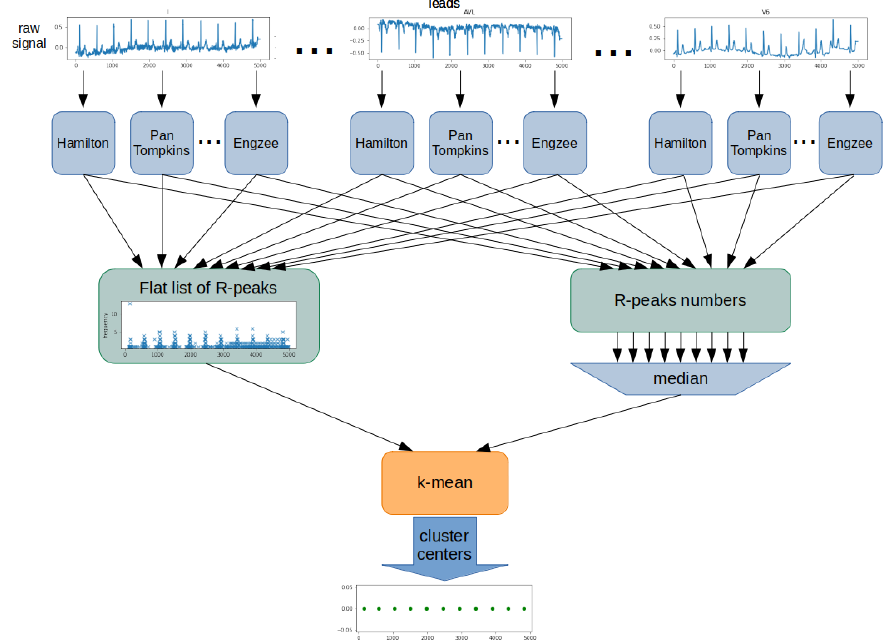
Figure 4. Block diagram of the proposed R-wave detection